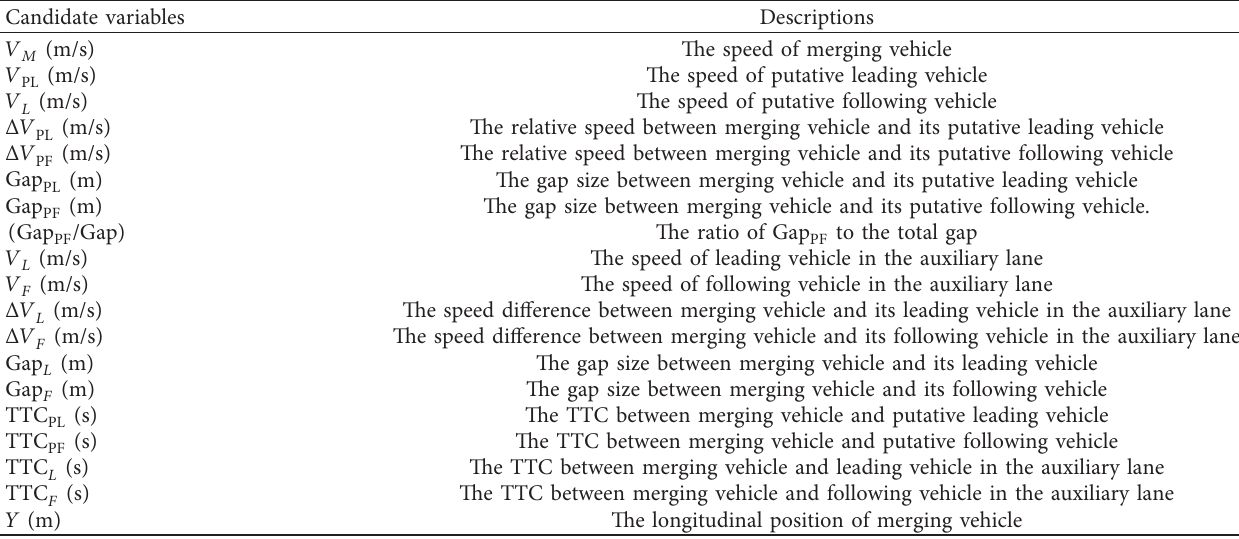
Figure 5: Schematic diagram of candidate variables. Table 2: Candidate variables and